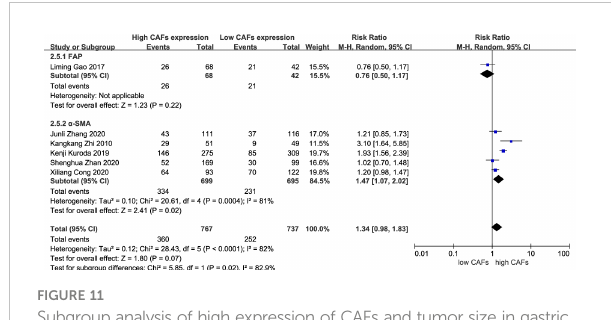
FIGURE 11 Subgroup analysis of high expression of CAFs and tumor size in gastric cancer. CAF, cancer-associated fi broblast; CI, con fi dence interval.